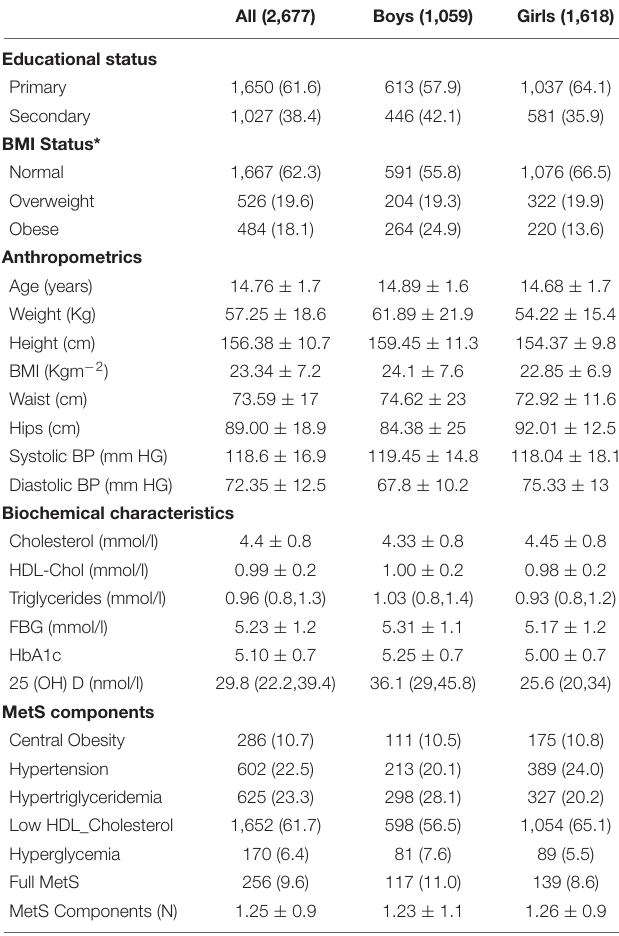
TABLE 2 | Characteristics of study participants at the time of recruitment.